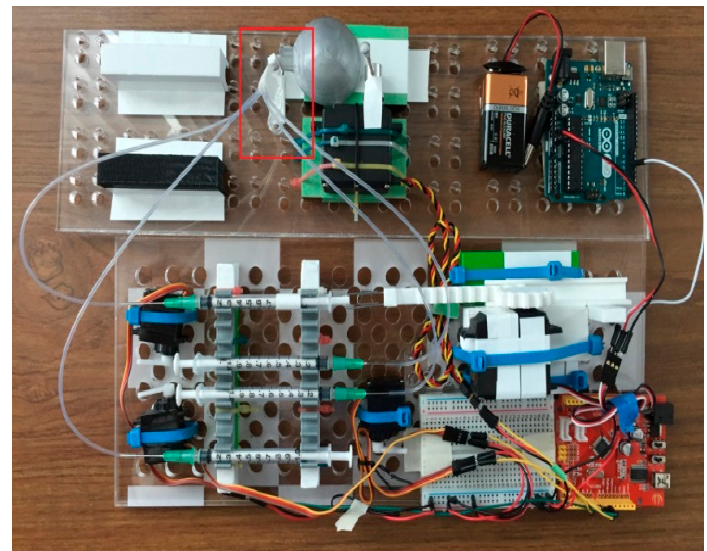
Figure 5. Top view of the assembled automated ELISA bioassay platform. Test wells are indicated by the red frame on the picture. See the caption of Figure 1 for a description of the individual